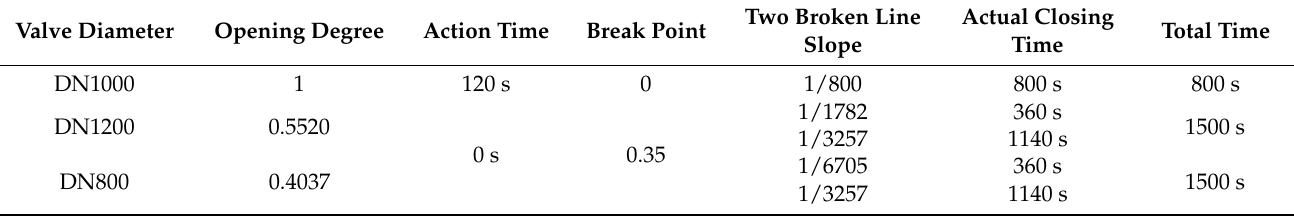
Table 2. Valve opening and closing rules for scheme c.